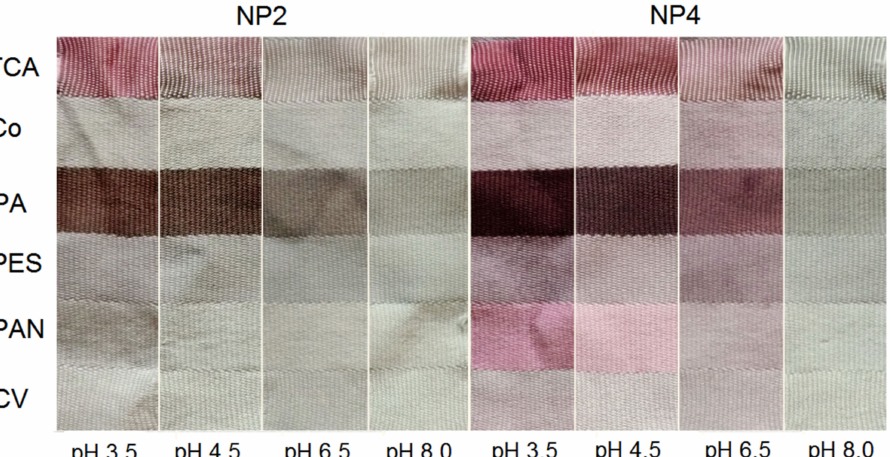
Figure 5. Multifiber fabric (TCA-cellulose triacetate, co-cotton, PA-polyamide, PES-polyester, PAN- polyacrylonitrile, CV-viscose) dyed with prodigiosin isolated from Streptomyces sp. strains NP2 and NP4 in dyebaths with different pH (reprinted with permission from reference [18]. Copyright 2014